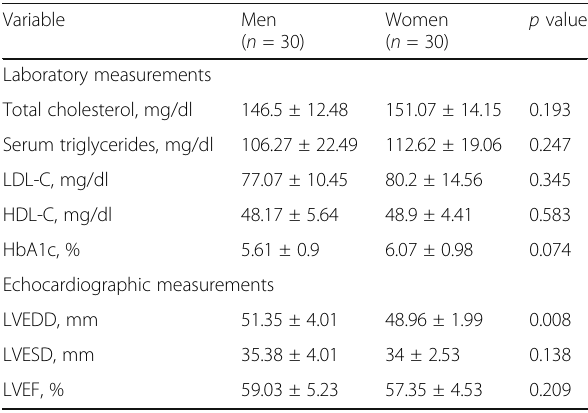
Table 5 Laboratory and echocardiographic measurements